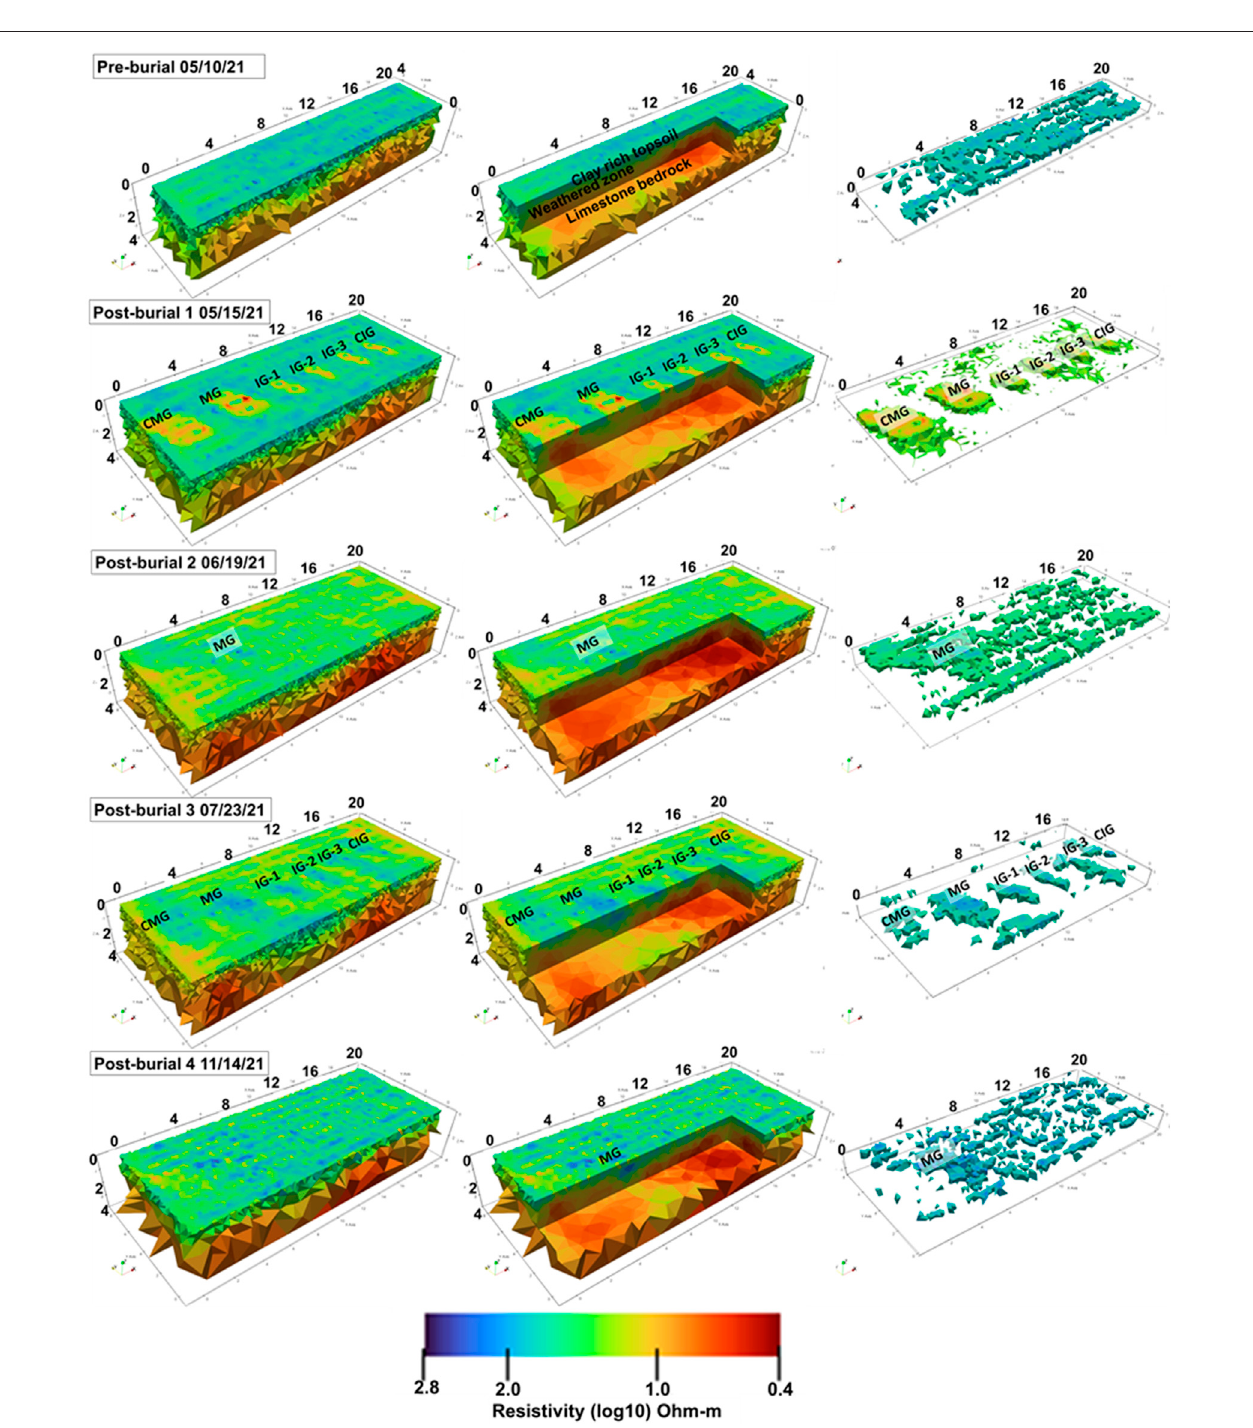
FIGURE7| Quasi-3Dresistivitydistributionobtainedbymergingnine2Dtransectsandinvertingwitha3Dinversioncode.Thecompleteresistivityvolumeshowing the outlines of the graves visible in post-burial 1 and 3 (rows 2 and 3) are show in column 1, the 3D volume sliced at 2 m × 4 m is shown in column 2 while a volume rendering highlighting 3D anomalies produced by the grave is shown in column 3.